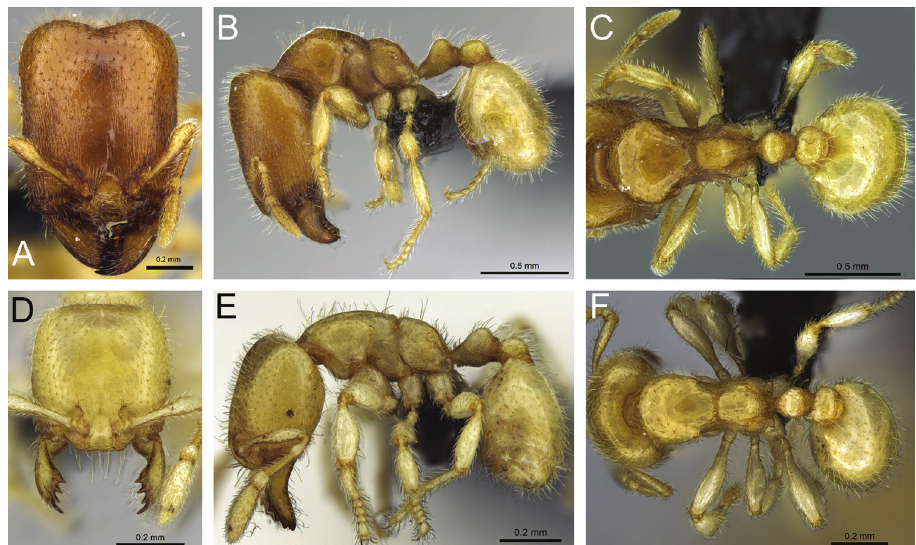
Figure 42. Carebara hiragasy –holotype. Major worker, CASENT0496886: A head in full-face view B body in profile view C body in dorsal view. Minor worker, CASENT0496888: D head in full-face view E body in profile view F body in dorsal